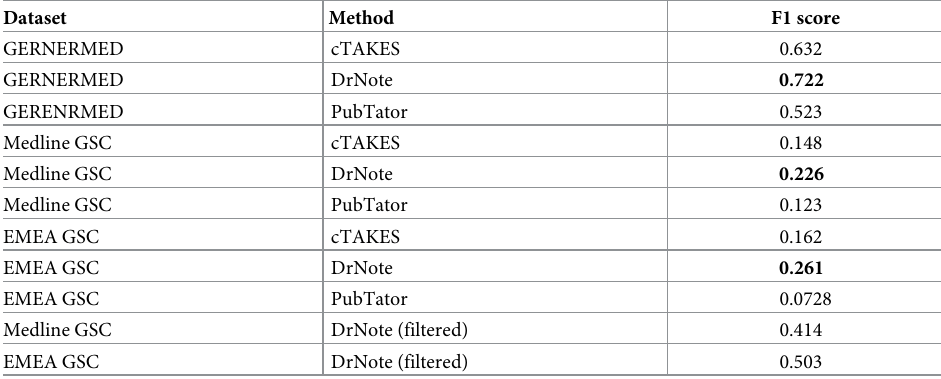
Table 2. Annotation Performance